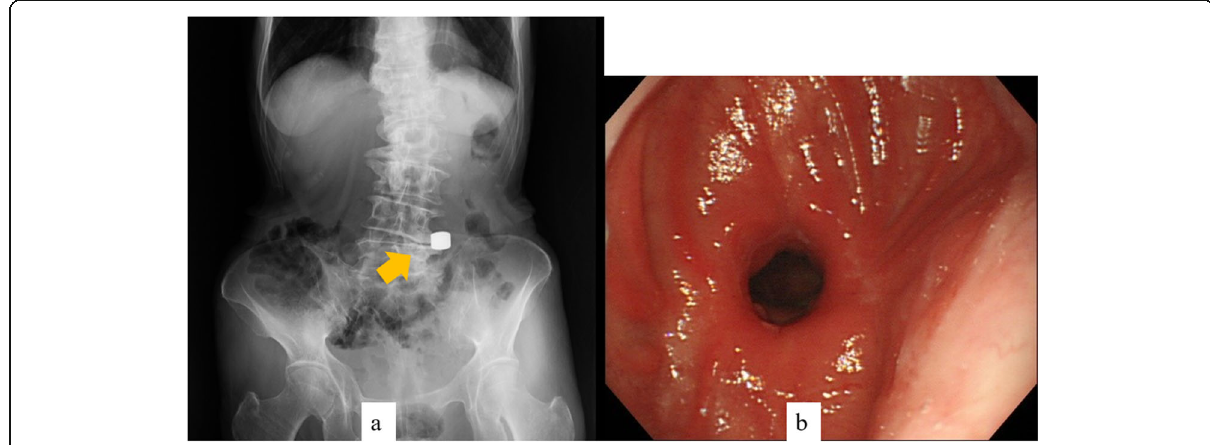
Fig. 6 Imaging of the created anastomosis. a Plain X-ray imaging: two magnets have moved to anal side (arrow). b Anastomosis observed by esophagogastroduodenoscopy after removal of the